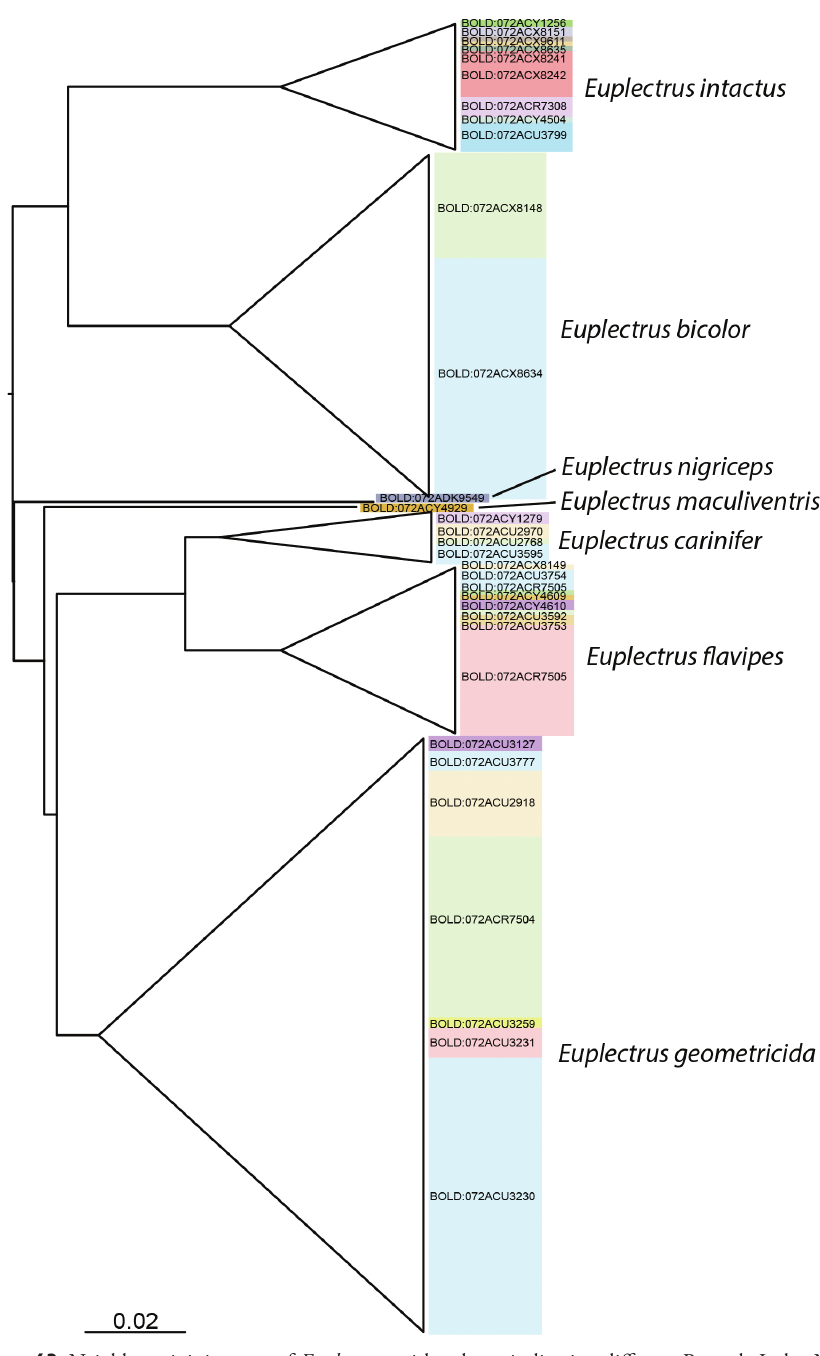
Figure 63. Neighbour-joining tree of Euplectrus , with colours indicating different Barcode Index Num- bers (BINs). For a fully resolved tree with additional terminal taxa information, including sequence length and country of origin, see Suppl. material